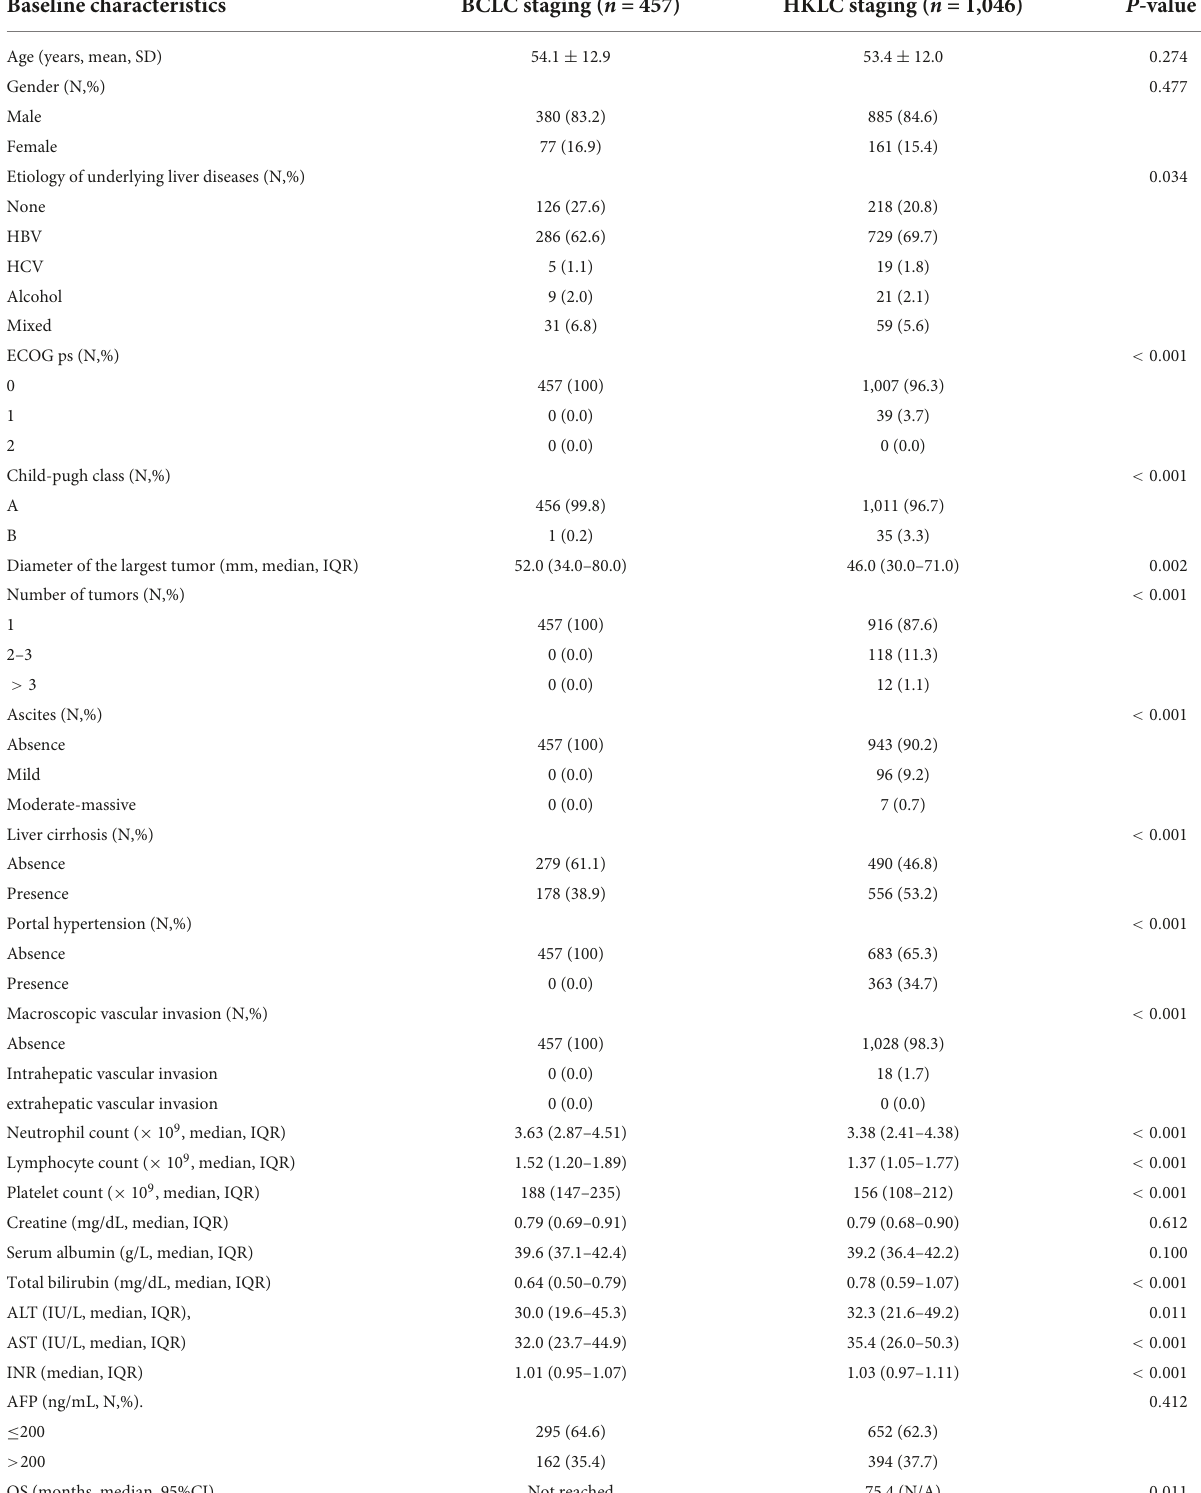
TABLE 2 Baseline characteristics of IPLRs in the BCLC and HKLC staging